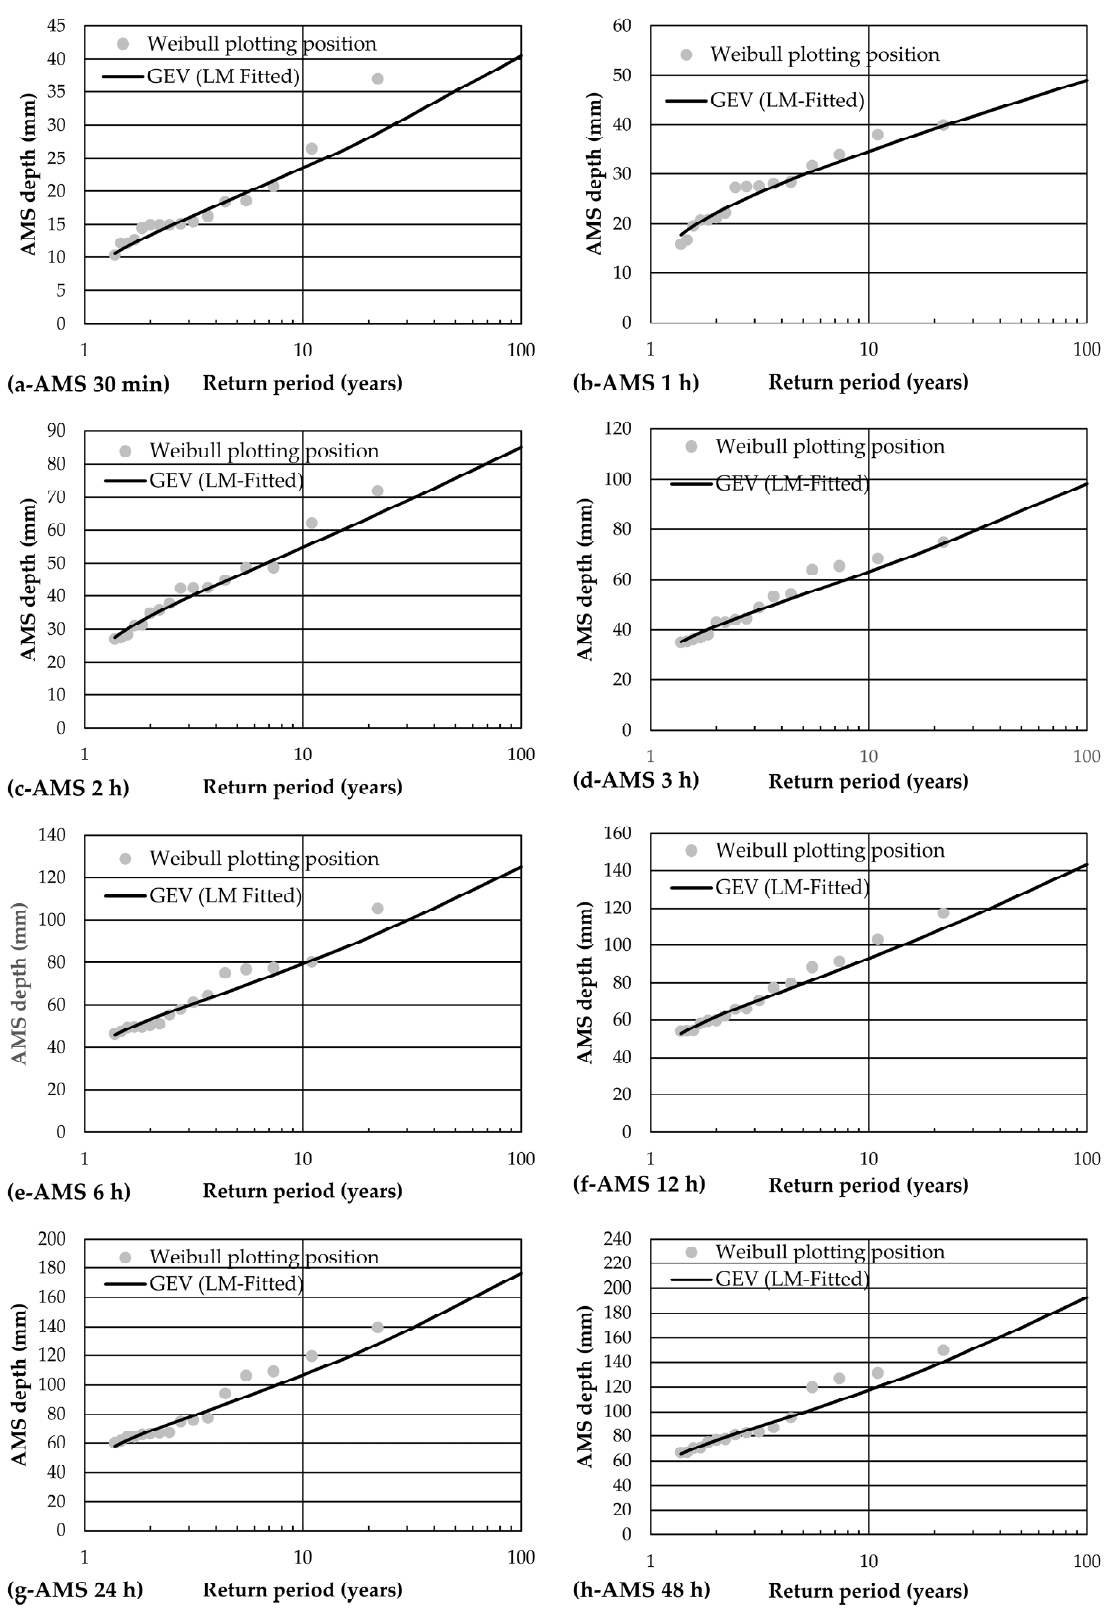
Figure 3. Distribution function plot for Annual Maxima Series (AMS) of various time scales and GEV fitted distributions (LM—Linear Moments).